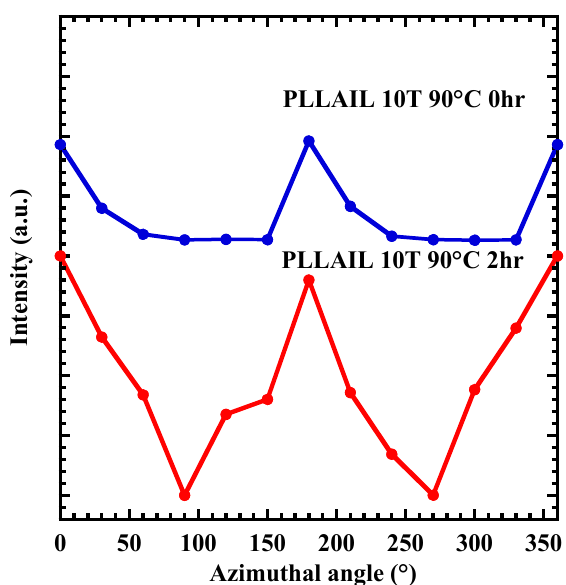
Figure 7. XRD (110)/(200) intensity along the azimuthal angle for PLLAIL10T and PLLAIL10T2 films.